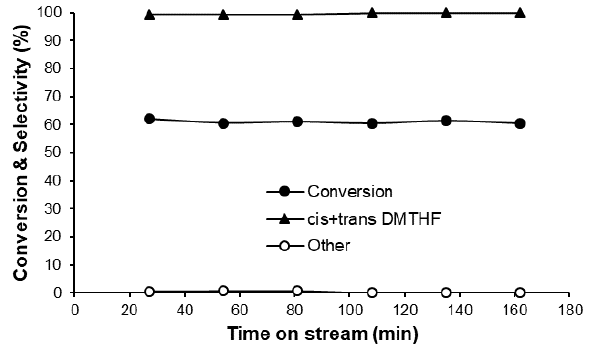
Figure 1. Time course for DMF hydroconversion over 7.0%Pt/C + SiO 2 catalyst (0.20 g total weight, 2.0 mg Pt / C) at 1.6 kPa DMF partial pressure, 70 ◦ C, 20 mL min − 1 H 2 flow rate, W / F = 2.5 g h mol − 1 .